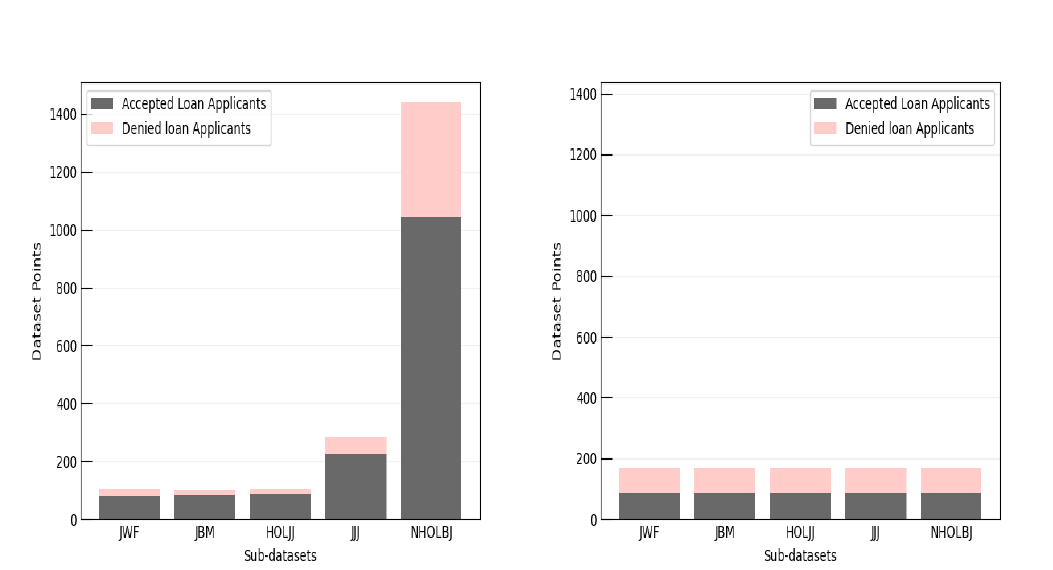
Figure 1. Class and label balancing before ( left graph) and after ( right graph) using DualFair. (Note: only 5 sub-datasets from the balancing procedure of Connecticut, a smaller sample of HMDA, are shown by the normal 27; note that J denotes joint, B denotes Black, W denotes White, F denotes female, M denotes male, HOL denotes Hispanic or Latino, and NHOL denotes Non-Hispanic or Latino. These denotations form sub-groups shown above. For instance, JJJ is a joint, joint, joint individual and HOLJJ is a Hispanic or Latino, joint, joint